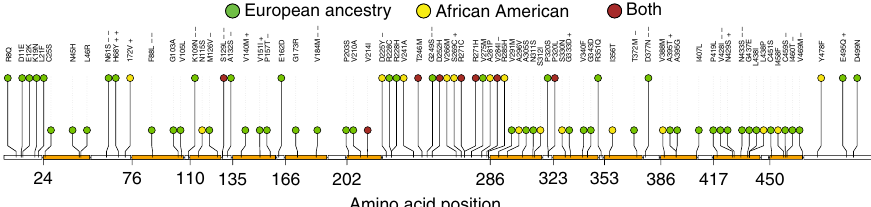
Fig. 4 Putative damaging variants with MAF < 5% in SLC2A9 (hSLC2Ab). Of the 90 variants included in primary gene-based test, 87 were missense, and 3 were splice variants. Of the 87 missense variants, 77 were found in the hSLC2A9b. The ± signs indicate variants selected for mapping onto the SLC2A9 predicted structure. Beta between − 1.5 and − 1.0 ( − ); beta < − 1.5 ( −− ); beta between 1.0 and 1.5 ( + ); beta >1.5 ( ++ ), Orange: predicted transmembrane domains. Amino acid position based on NP_001001290 (ENSP00000422209)